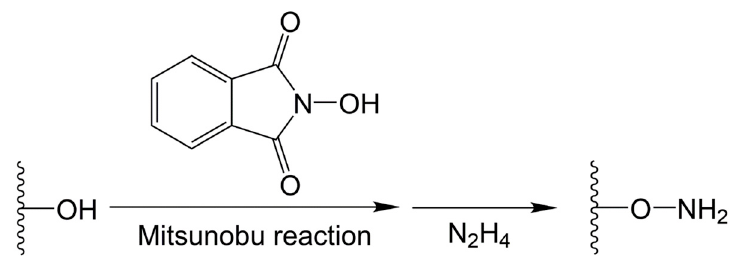
Figure 5. Synthesis of aminooxy-functionalized polymers using the Mitsunobu reaction coupling with hydroxyphthalimide, followed by deprotection with hydrazine (N 2 H 4 ).